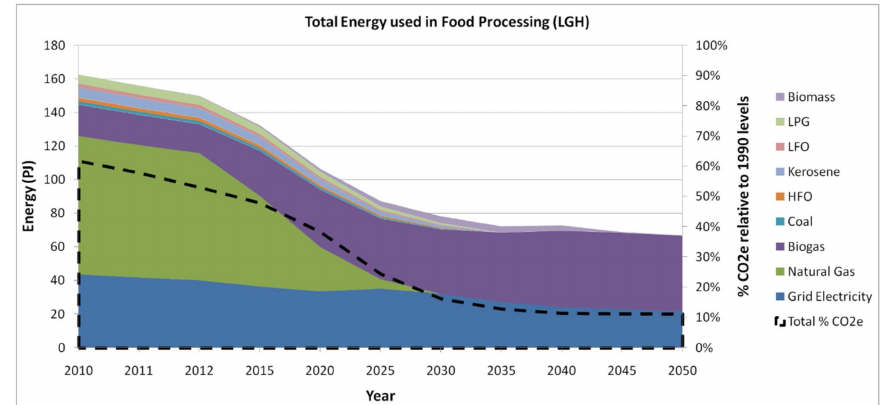
Figure 6. Energy consumption and emissions for the 80% GHG reduction scenario. (Note that legends and colours in Figures 5 and 6 are aligned in sequential order for ease of interpretation).